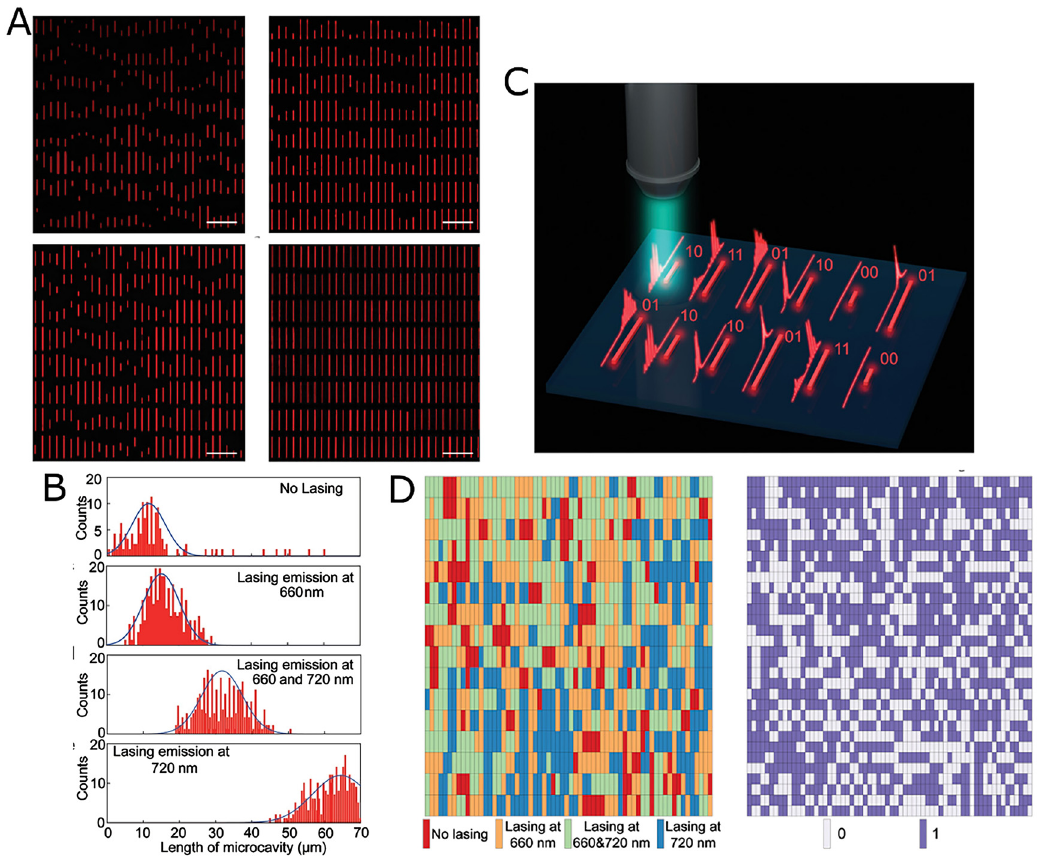
Figure 7: Optical cryptography. (A) Organic nanolaser arrays with stochastic size distribution dependent on the organic solution used during fabrication. Scale bar: 100 µm. (B) Distribution of cavity lengths for four distinct emission states. The distribution illustrates how the length of the nanolaser determines the emission state. (C) Scanning of each individual nanolaser with a pump pulse. Depending on the emission state, the spectral information can be encoded as a bit. (D) Cryptographic sequence generated by treating emission states as quaternary bits (left) and double binary bits (right). Adapted and reprinted from a study by Feng et al. [60] with